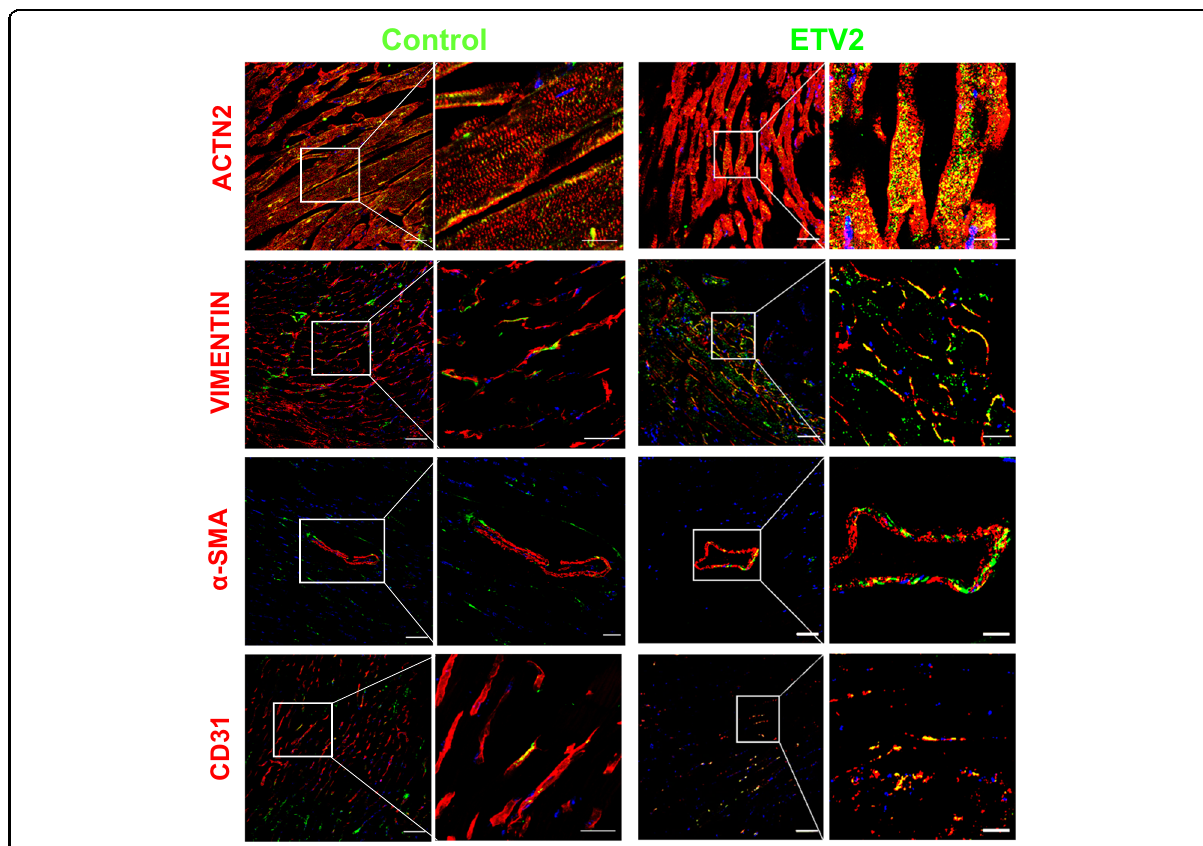
Fig. 1 In vivo transduction of ETV2 into MI hearts. Representative confocal immuno fl uorescent images of sectioned heart tissues harvested 3 days after injection of control or ETV2-Ires-VENUS lentivirus into MI hearts. Anti-ACTN2, VIMENTIN, α -SMA, or CD31 in red and DAPI for nuclei in blue. Scale bars: 50 µm for merged and 20 µm for enlargement (far right